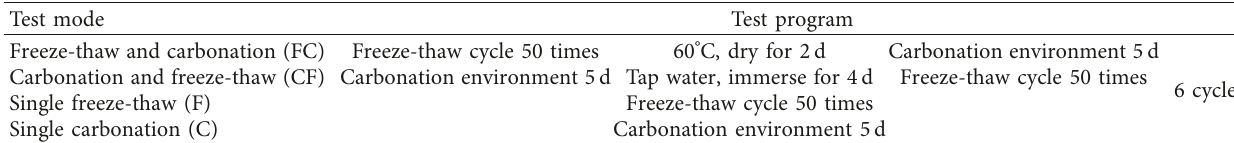
Table 5: Grouping of the test.